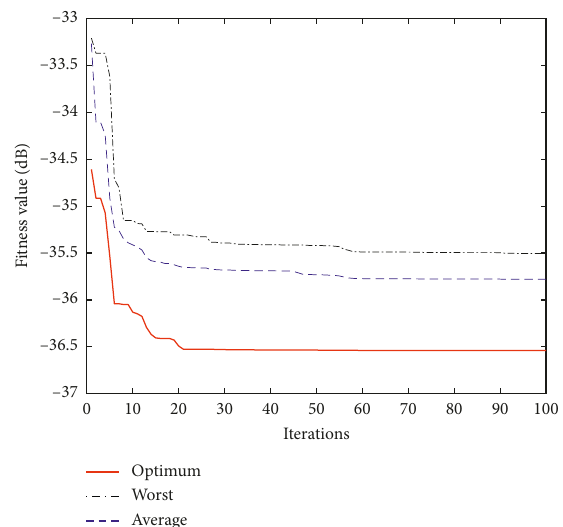
Figure 5: Fitness curve of the PSO-CVX